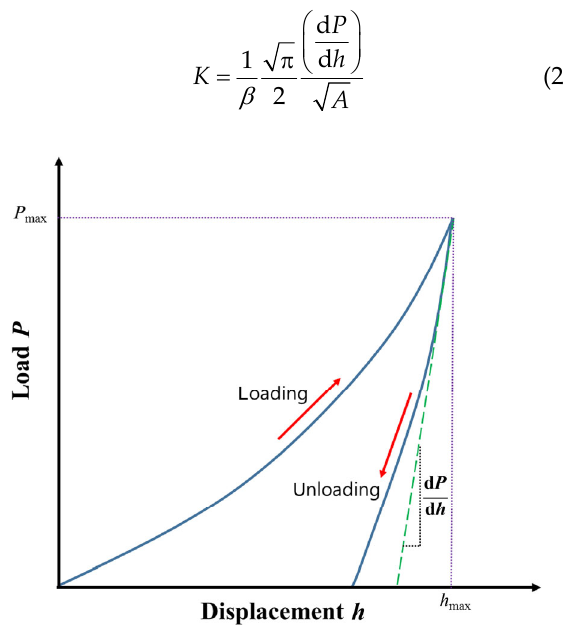
Fig. 1 Schematic diagram of a typical load displacement curve during an indentation